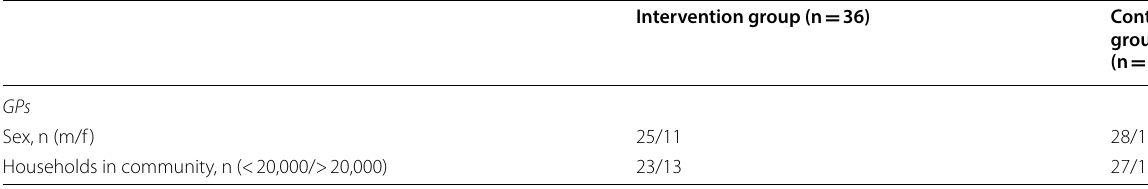
Table 1 Descriptive characteristics of the GPs and the patient characteristics at